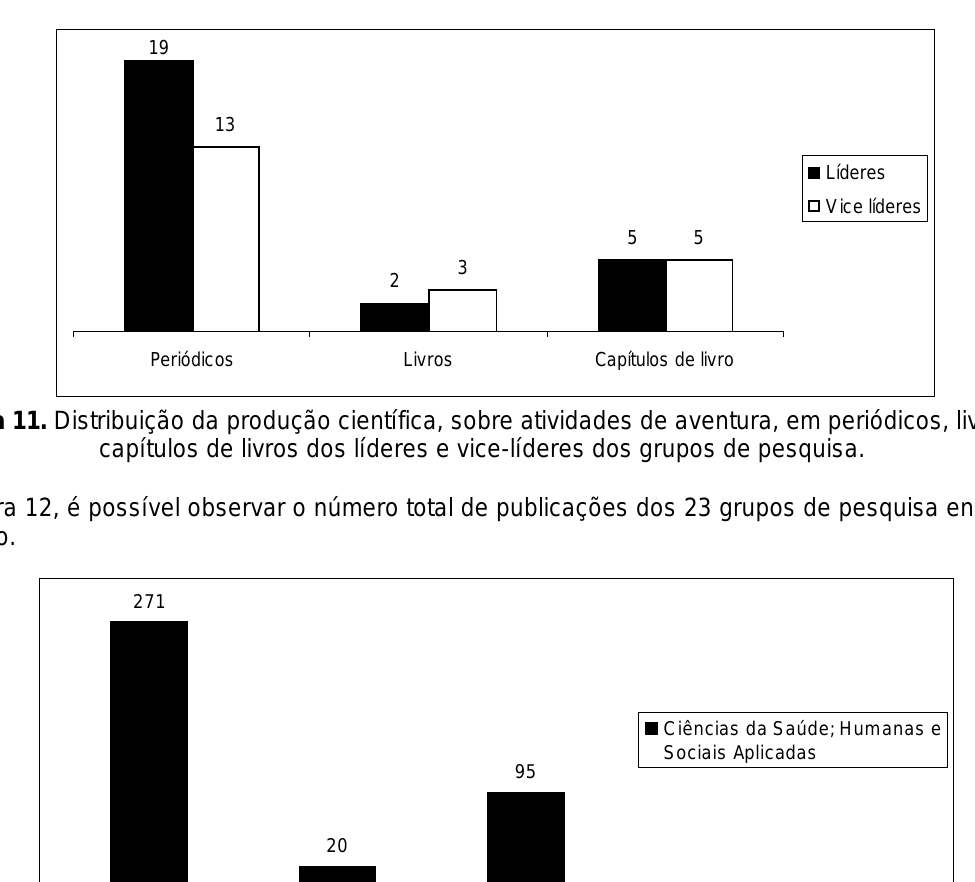
Figura 10. Distribuição da produção científica dos grupos de pesquisa, sobre as atividades de aventura, durante o triênio 2006, 2007 e 2008, por área de conhecimento. Observa-se que não houve uma diferença significativa entre os líderes e vice-líderes dos grupos de pesquisa no que se refere ao número de publicações realizadas em periódicos, em livros e em capítulos de livros durante o triênio 2006, 2007 e 2008, como demonstra a figura 11.